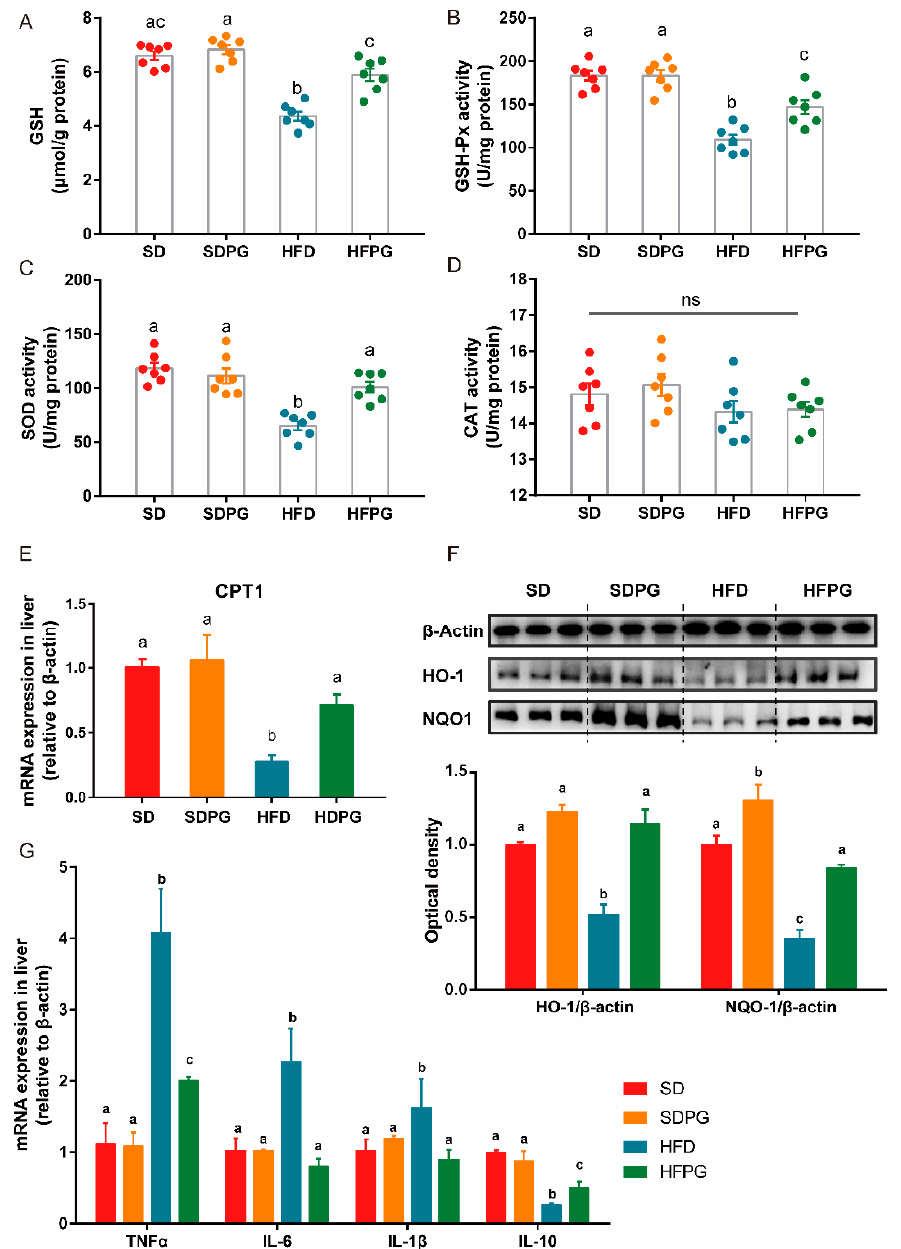
Figure 5. PG reduces hepatic oxidative stress in HFD-fed mice. ( A ) Liver GSH content. Activities of ( B ) GSH-Px, ( C ) SOD1, and ( D ) CAT, ns means no significant difference. ( E ) mRNA expression of CPT1 in liver analyzed by RT-qPCR. ( F ) Western blot analysis for HO-1, NQO1, and β -actin in liver tissues. ( G ) Fold change in relative expression of HO-1/ β -actin and NQO1/ β -actin in protein level. a, b, c means in the same bar without a common letter differ at p < 0.05.